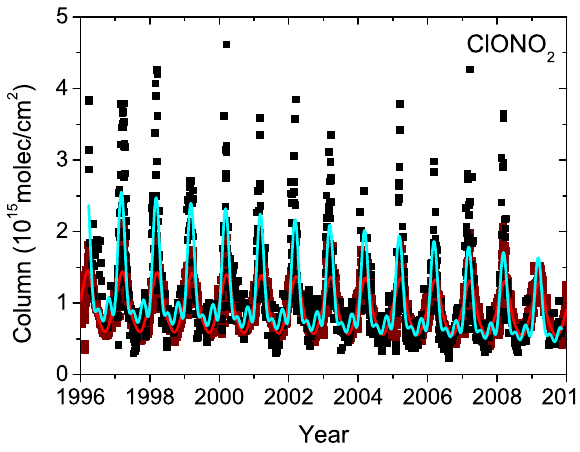
Fig. 5. Time series of FTIR measurements (black squares) and KASIMA model data (dark red squares) of ClONO 2 above Kiruna from 1996 to 2009 and the least squares fits of Eq. (1) to the mea- surements (cyan line) and model data (red